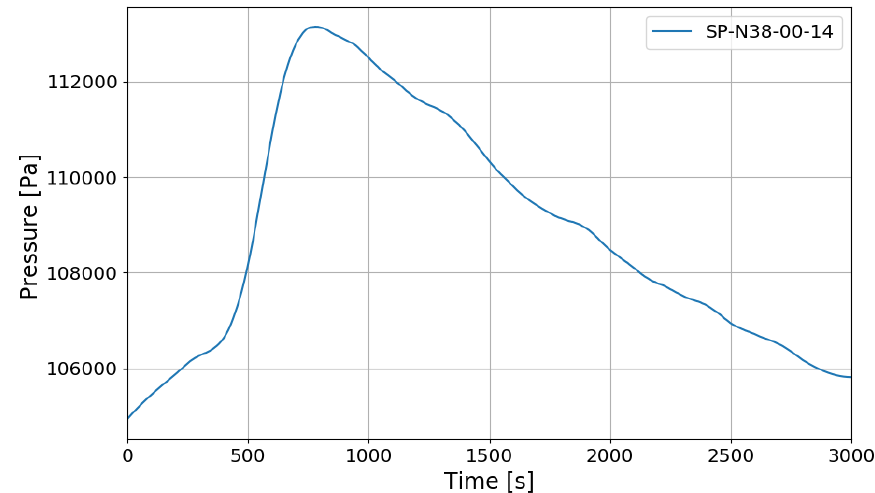
Figure 9. SPARC internal pressure change in SP1 experiment.